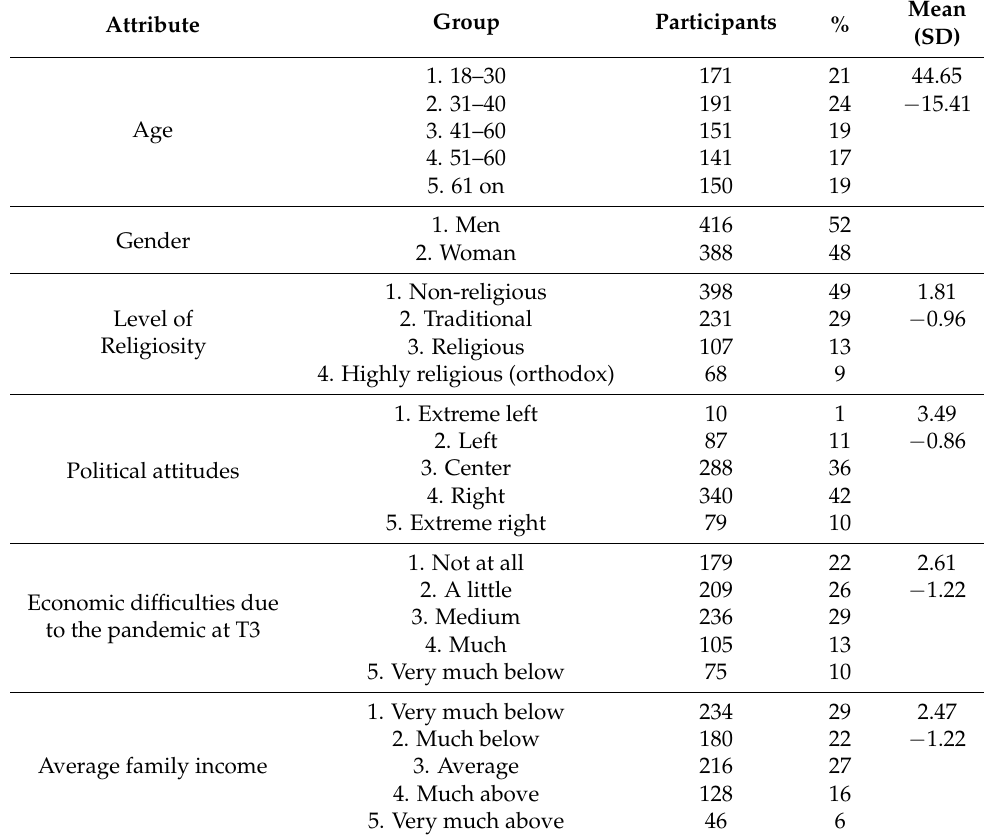
Table 1. Characteristics of the study sample ( N =